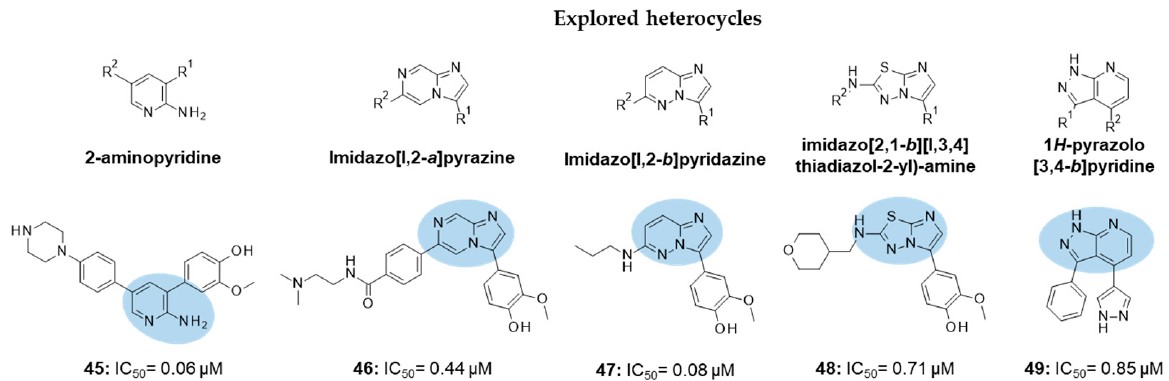
Figure 9. Explored heterocycles ( top ) and representative examples ( bottom ) of FYN inhibitors developed by Lau [131].